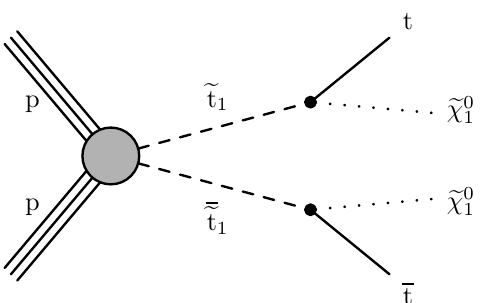
Figure 1 . Diagram of the top squark pair production with further decay into a top (antitop) quark and the lightest